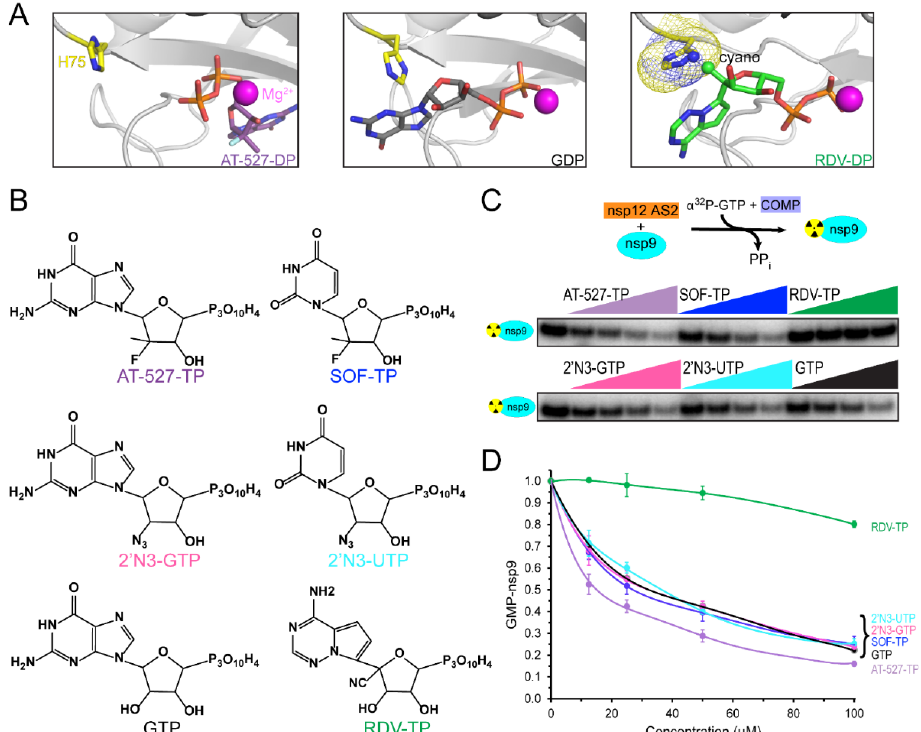
Figure 2. Competition of nucleotide analogs for nsp9 modification. ( A ). Nucleotide binding to the NiRAN active site. The Mg 2+ ion is shown as a magenta sphere and the His75 residue in the NiRAN active site (AS2) as sticks. Left, AT-527 diphosphate (shown as purple carbon atoms; PDB ID: 7ED5). Center, GDP (black carbon atoms; PDB ID: 7CYQ). Right, RDV-DP (green carbon atoms) was mod- eled in place of ADP (PDB ID: 6XEZ); the C 1′ cyano group of RDV could clash with His75. Structural figures were prepared with PyMOL Molecular Graphics System, version 2.5.2, Schrodinger, LLC (New York, NY, USA). ( B ) . Structures of nucleotide analogs tested for competition with [α 32 P]-GTP for transfer to nsp9; these were prepared with ChemDraw 20.1. The color scheme is preserved in all panels. ( C ). Effects of NAs shown in panel B on nsp9 NMPylation by nsp12. Top: the assay sche- matic; nsp9 and nsp12 were incubated in the presence of [α 32 P]-GTP and indicated analogs. Bottom: [α 32 P]-GMP-nsp9 was detected by protein gel analysis. A representative gel loaded with reactions containing 25 μM GTP and analogs added at 12.5, 25, 50, and 100 μM, from left to right. ( D ). NMPyl- ation efficiency was compared to that observed in the absence of competitors, set at 1, and is shown as mean ± SD (n = 3).